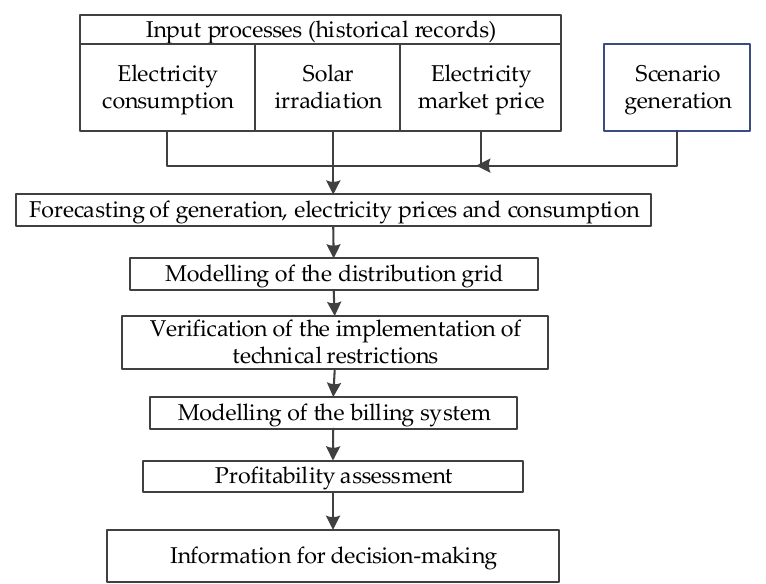
Figure 3. The structure of the decision-making algorithm.